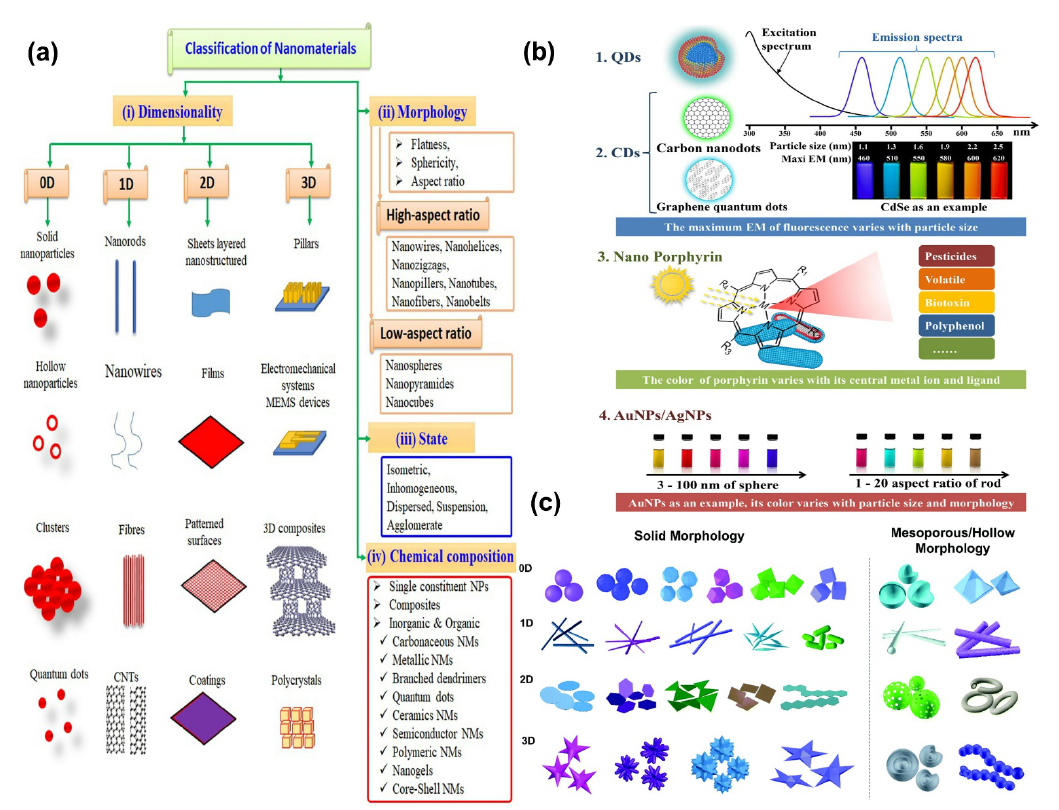
Figure 3. ( a ) Schematic illustration of nanomaterials classification. Adapted with permission from [81] Copyright 2020 Elsevier ( b ) and their optical properties. Adapted with permission from [93] Copy- right 2021 Elsevier. ( c ) Typical morphologies of solid and mesoporous/hollow inorganic nanoparticles with 0D, 1D, and 2D shapes and other 3D complex structures. Adapted with permission from [94]. Copyright 2016 Royal Society of